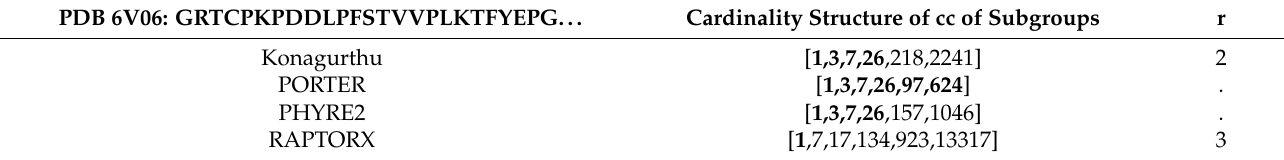
Table 3. Group analysis of apolipoprotein-H (PDB 6V06). The bold numbers means that the cardinality structure of cc of subgroups of f p fits that of the free group F 3 when the encoding makes use of 2 letters. The first model is the one used in the previous Section [24] where we took 4 = H and T = C . The other models of secondary structures with segments E, H and C are from softwares PORTER, PHYRE2 and RAPTORX. The references to these softwares may be found in our recent paper [3]. The notation r in column 3 means the first Betti number of f p . PDB 6V06: